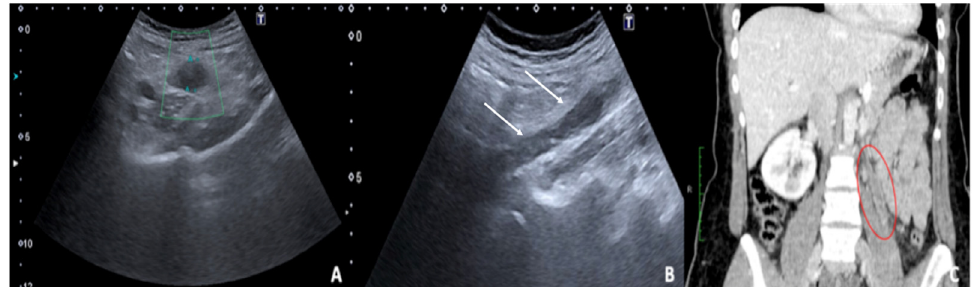
Figure 16. Thrombosis of the right gonadal vein. TSA–US scan of the left ovarian vein in axial ( A ) and longitudinal ( B ) view before delivery show the ovarian vein as a tubular structure with heterogeneous hypoechoic echotexture (( B ) arrows), located superiorly to the ovary and anteriorly to the psoas muscle. Contrast-enhanced CT coronal image ( C ) was performed after delivery and confirmed the left gonadic vein thrombosis (red circle). Reprinted with permission from Caruso, M.; Dell’Aversano Orabona, G.; Di Serafino, M.; Iacobellis, F.; Verde, F.; Grimaldi, D.; Sa-